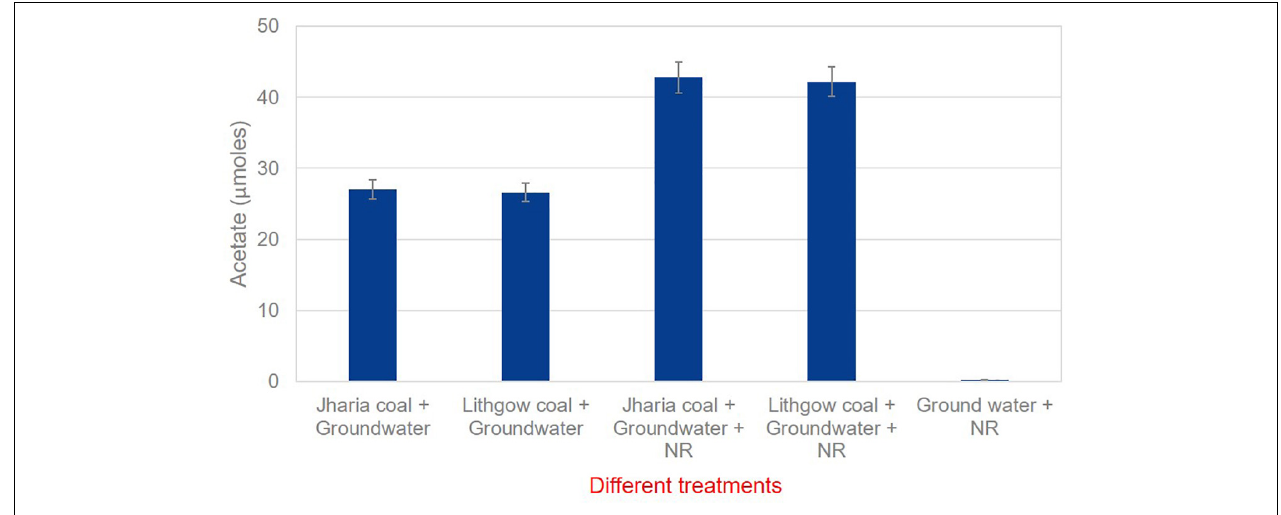
FIGURE 4 | GC data showing the acetate production in the presence and absence of neutral red with Jharia coal and Lithgow coal.